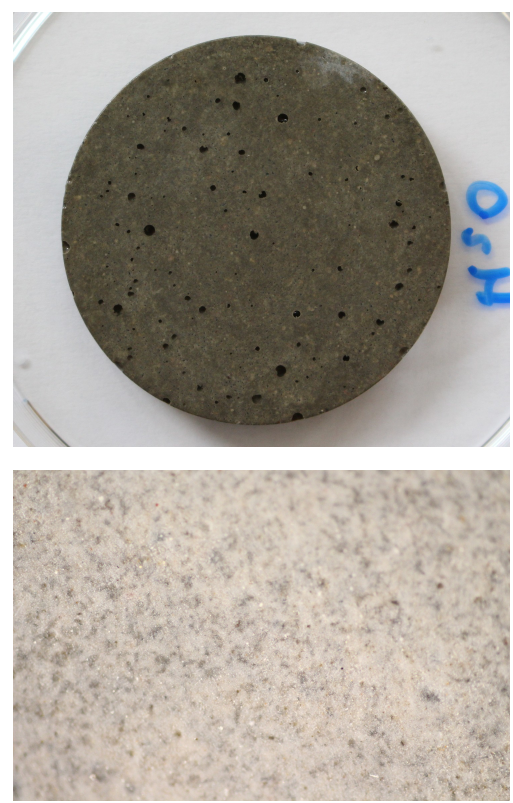
Figure 9. Surface of the specimen placed in solution of bacteria in 253 media in 2% CaCl